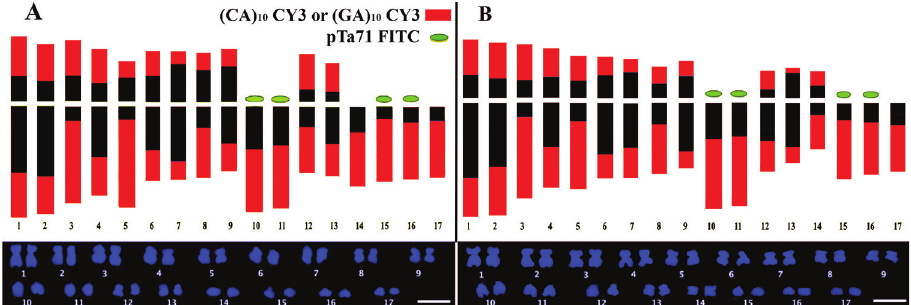
Figure 8. Ideogram with molecular characterization of cardoon and globe artichoke complement. Ideo- gram showing chromosome morphology (in black) and the (CA) sequence (green) distribution on cardoon ( A ) and globe artichoke ( B ) complement. The two di-nucleo- tides localize at similar chromosome regions. Scale bar: 5